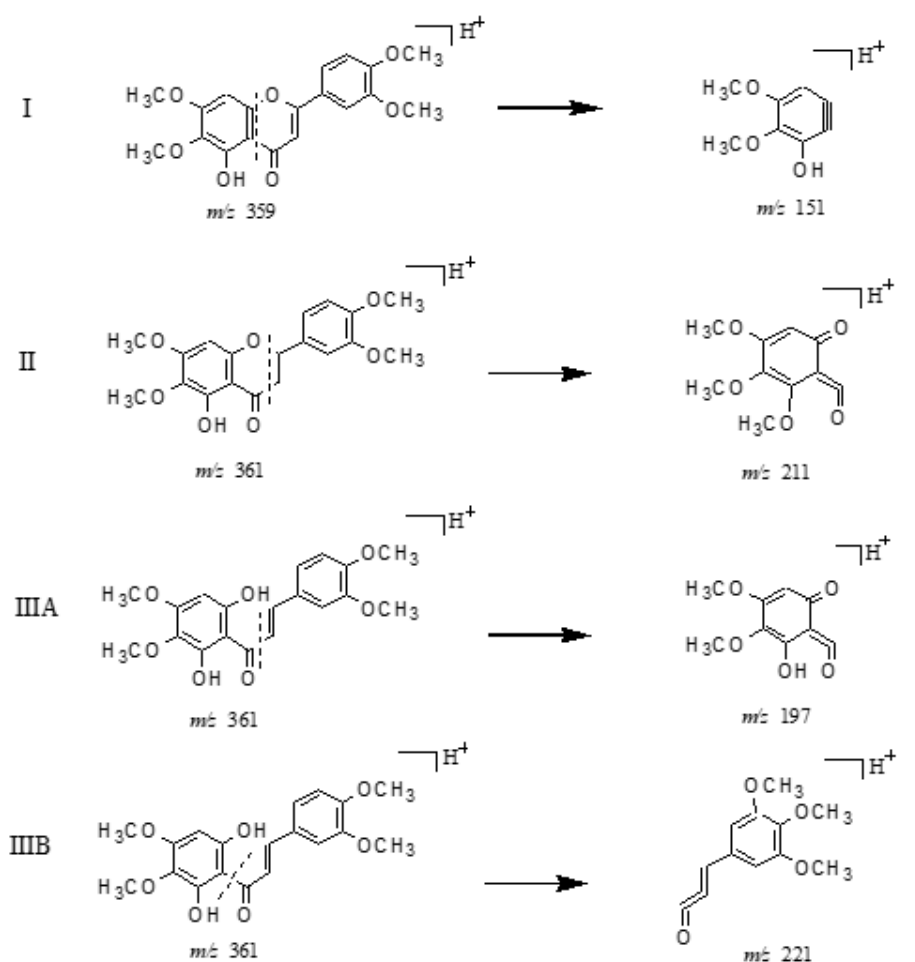
Figure 3. The proposed fragmentation pathways for polymethoxyflavones, polymethoxyflavanone, and polymethoxychalcone